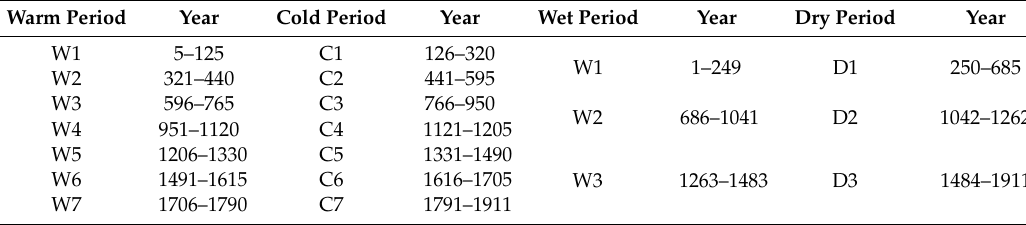
Figure 1. (a) Paleotemperature anomaly under the seven-cycle scheme. Note: The annual and 50-year FFT-smoothed series are colored in yellow and red, respectively. Seven cold phases are highlighted in cyan bars. (b) Paleoprecipitation reconstruction under the three-cycle scheme. Note: The annual and 300-year curves (smoothed by Butterworth low-pass filter) are shown in cyan and blue, respectively. Three dry intervals are marked by yellow bars. Table 1. Divisions of warm (W)/cold (C) and wet (W)/dry (D) cycles in ancient China, 1–1911 CE